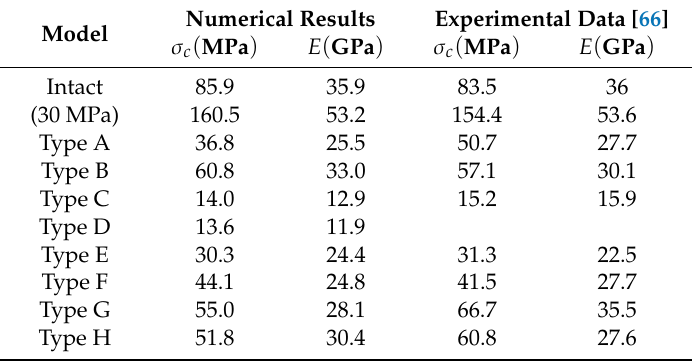
Table 3. Comparison of macro-mechanical properties of